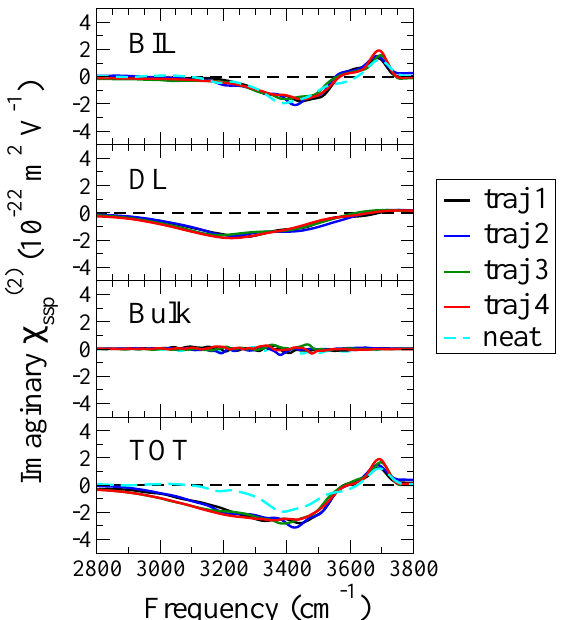
Figure 5. Theoretical phase-resolved SFG. Im χ ( 2 ) ( ω ) spectra calculated from the four DFT-MD simulations, considering only the water molecules in the BIL, only the water molecules in the DL, only the water molecules in the Bulk, and all the water molecules. The total and deconvolved SFG spectra calculated for the neat air-water interface [22] are also reported for comparison